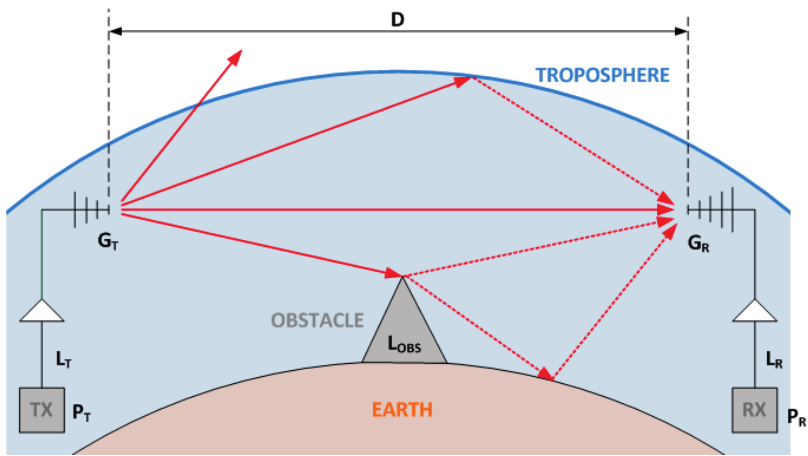
Figure 5. Signal transmission model in an outdoor environment with